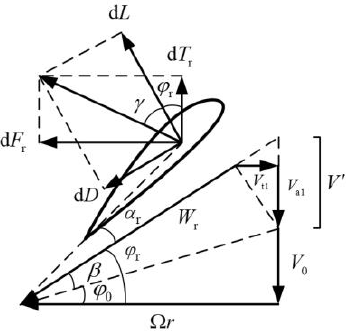
Figure 7. Schematic diagram of rotor element analysis.